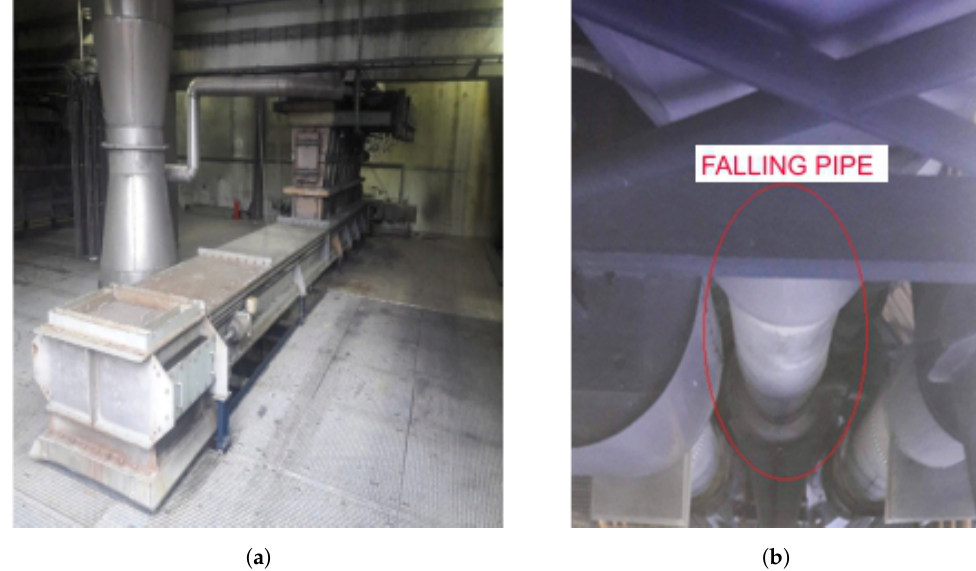
Figure 2. Main components of the coal feeding subsystem are ( a ) the coal feeder; and ( b ) the falling